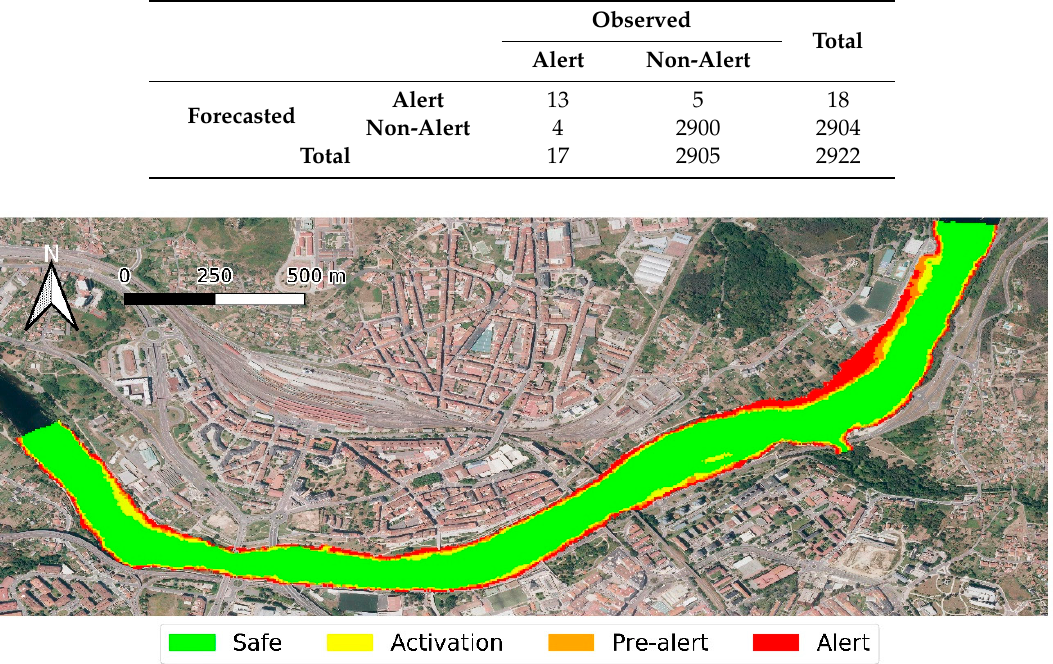
Figure 9. Maximum extents of the hazardous area under the different alert stages.